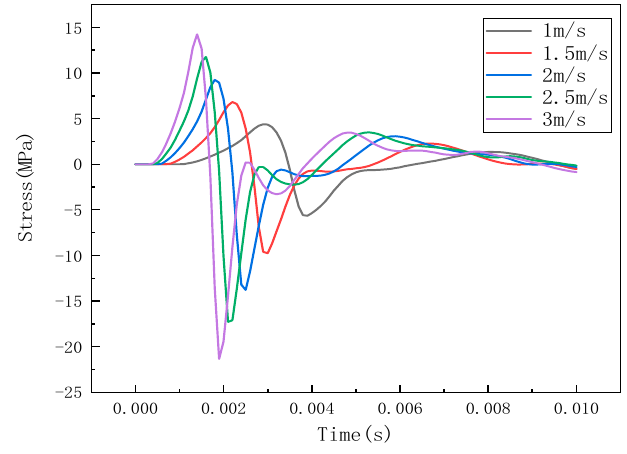
Figure 14. Stress curve of detection point at impact at position 3.